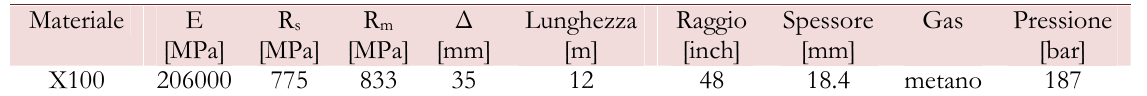
Tabella 1: Caratteristiche del